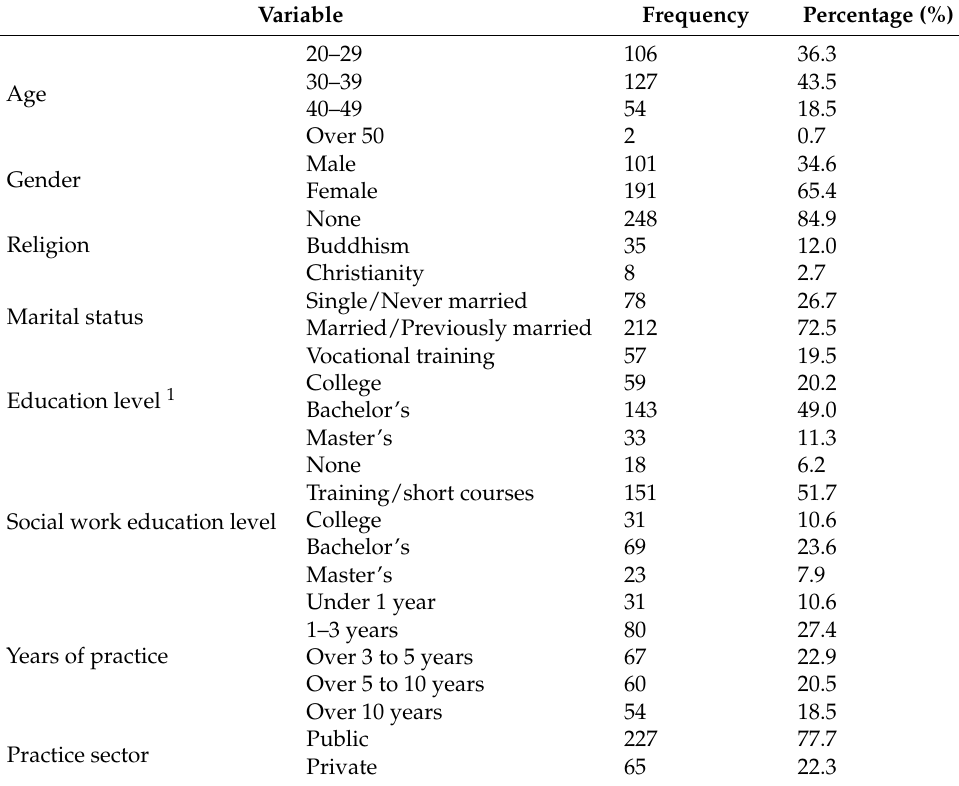
Table 1. Demographic information of participants ( n =